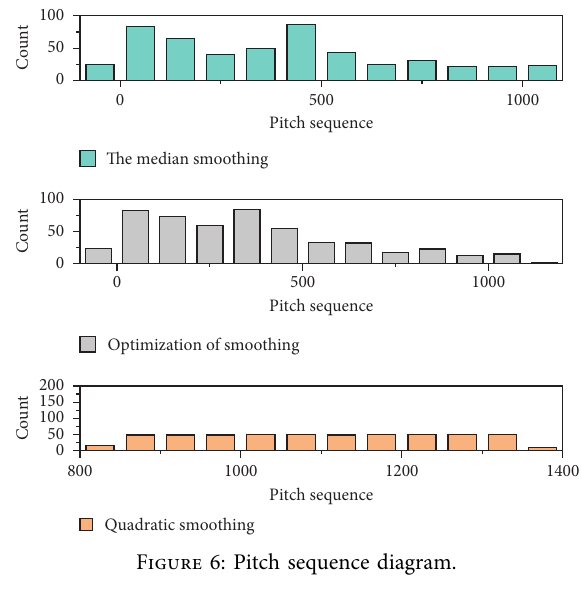
Figure 6: Pitch sequence algorithm for pitch sequence similarity calculation, it is possible to match by subsequence, which can reduce the computation time of the algorithm exponentially.